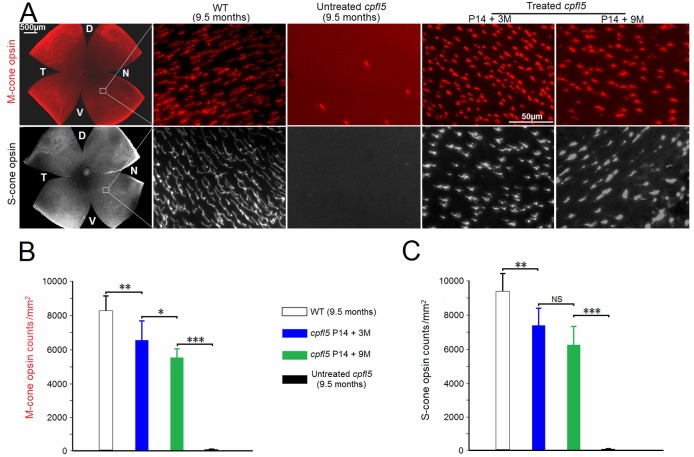
M-cone and S-cone opsins preservation in retinal whole mounts after treatment.At 3 and 9 months after P14 treatment with AAV8 (Y447, 733F + T494V)-IRBP/GNAT2-Cnga3, M-cone opsins (red) and S-cone opsins (white) were imaged (A) and counted (B, C) in the same field of ventral nasal retina (n = 6). WT and untreated cpfl5 mice were used as controls. D, dorsal; V, ventral; T, temporal; N, nasal. P, postnatal day; M, months. *indicates P < 0.05, **indicates P < 0.01, ***indicates P < 0.001, NS = no statistical difference.